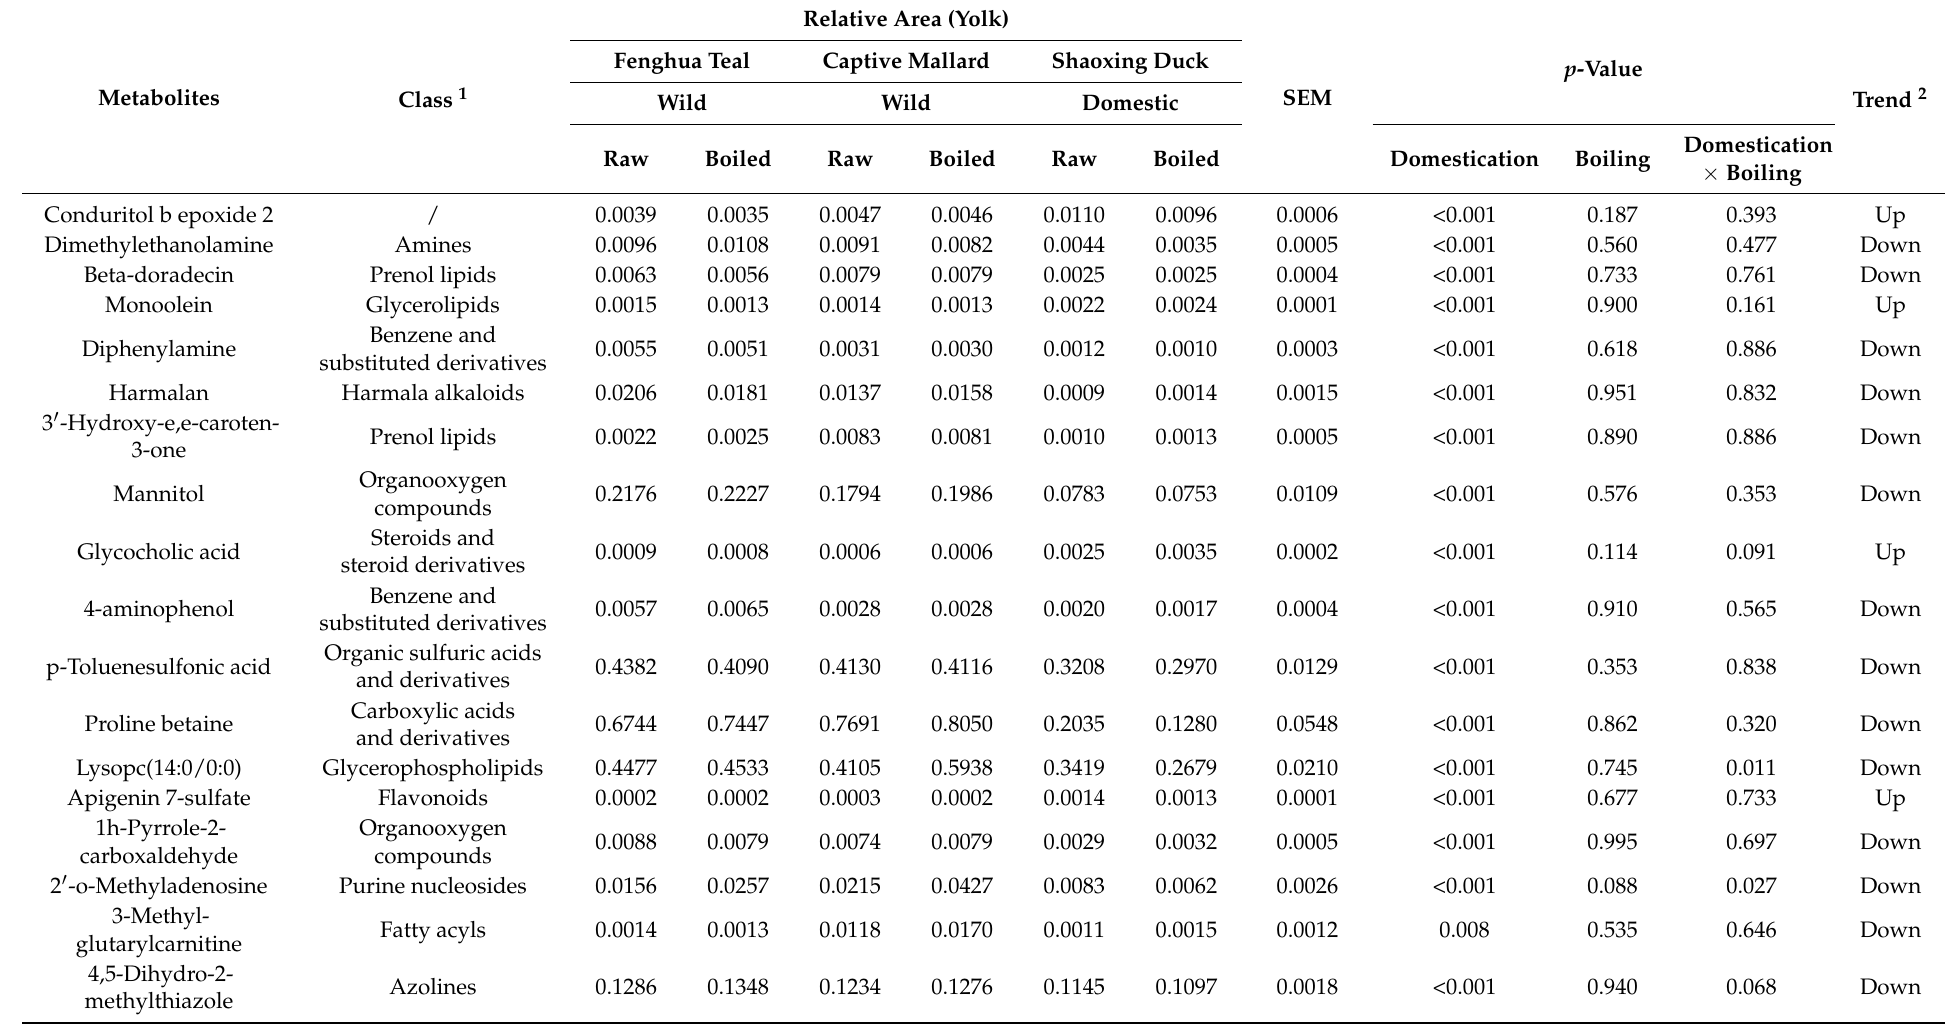
Table 1. Metabolites with domestication-induced